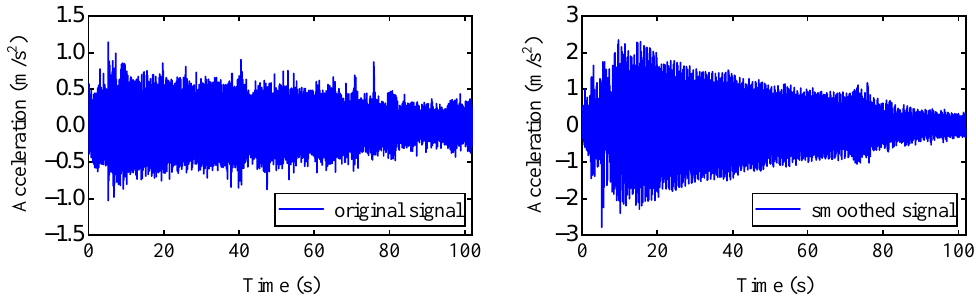
Figure 3. Condition 1 of scale model experiment: original and smoothed cable vibration signal processed by Equation